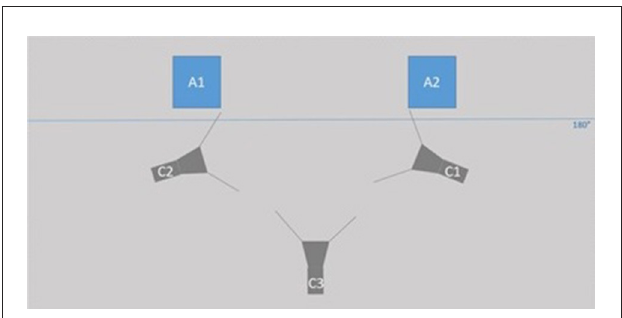
FIGURE1 Experimental design. A1: actor 1 recorded with C1, A2: actor 2 recorded with C2; C1: camera 1 directed on A1 (close shot), C2: camera 2 directed on A2 (close shot), and C3: camera 3 (medium-long